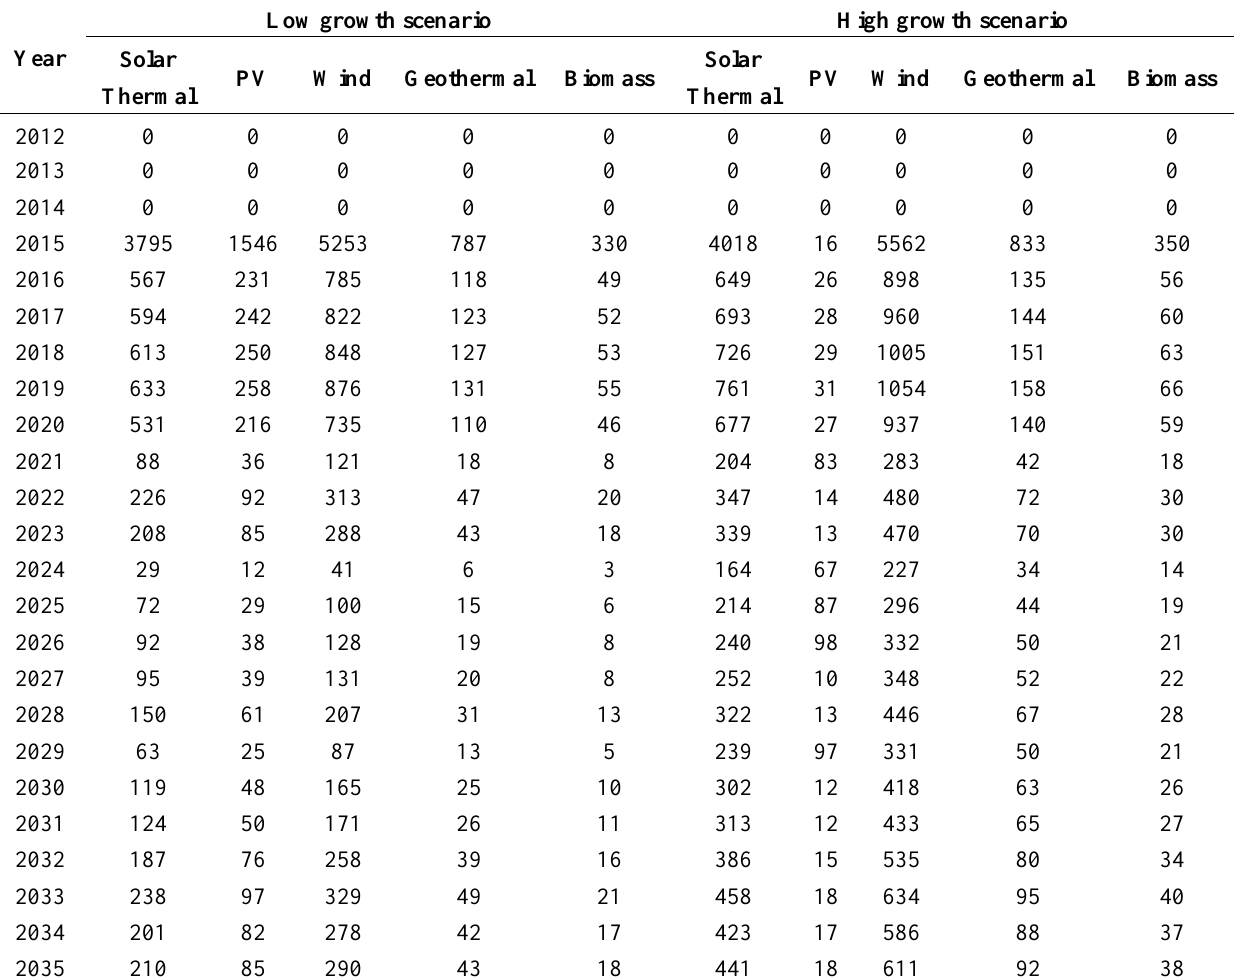
Table 2. Renewable energy resources added within California in MW as a result of